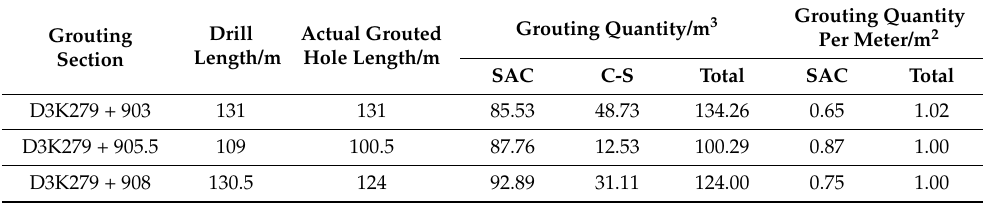
Table 5. Implementation of grouting in Yujingshan tunnel left